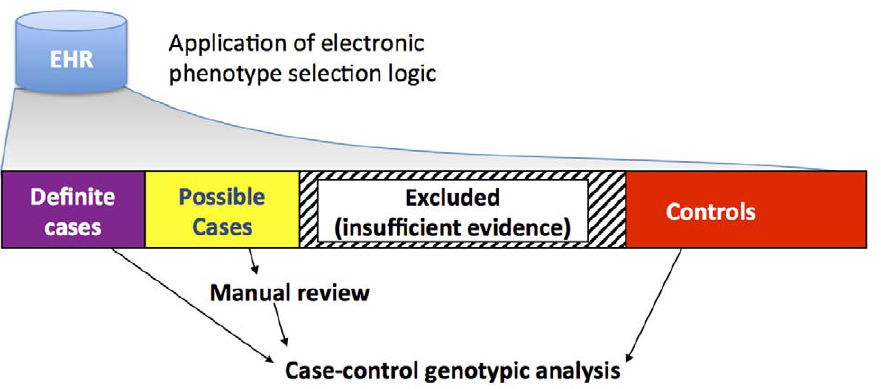
Figure 3. General figure for identifying cases and controls using EHR data. Application of electronic selection algorithms lead to division of a population of patients into four groups, the largest of which comprises patients who were excluded because they lack sufficient evidence to be either a case or control patient. Definite cases and controls cross some predefined threshold of positive predictive value (e.g., PPV $ 95%), and thus do not require manual review. For very rare phenotypes or complicated case definitions, the category of ‘‘possible’’ cases may need to be reviewed manually to increase the sample size.